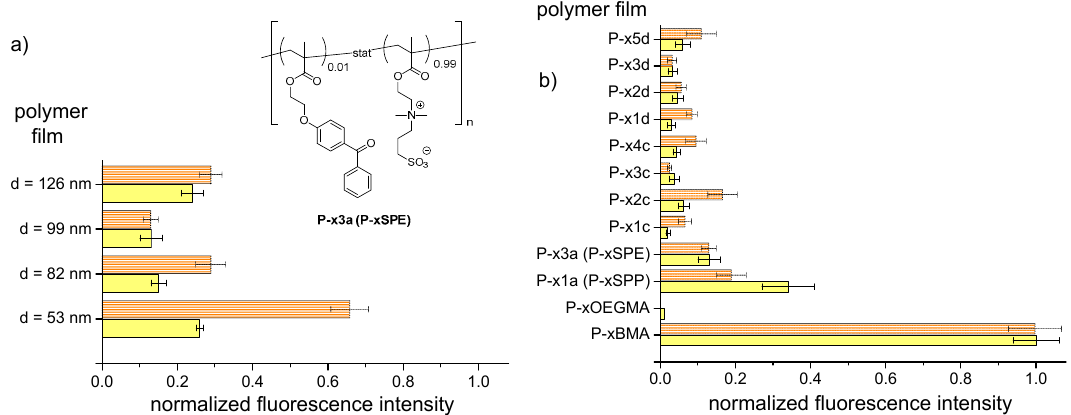
Figure 7. Adsorption of fluorophore-labeled proteins fibrinogen (orange bars) and BSA (yellow bars) from PSB solution onto polyzwitterion hydrogel coatings, according to the sample’s fluorescence intensity after exposure (intensities normalized to the intensities measured for P − xBMA): ( a ) Upon variation of the hydrogel film thickness for P − x3a (P − xSPE); ( b ) upon variation of the polyzwitterion structure, while keeping film thickness at about 100 nm. Films of the nonionic P − xOEGMA and the hydrophobic P − xBMA are used as references (positive and negative control, respectively).